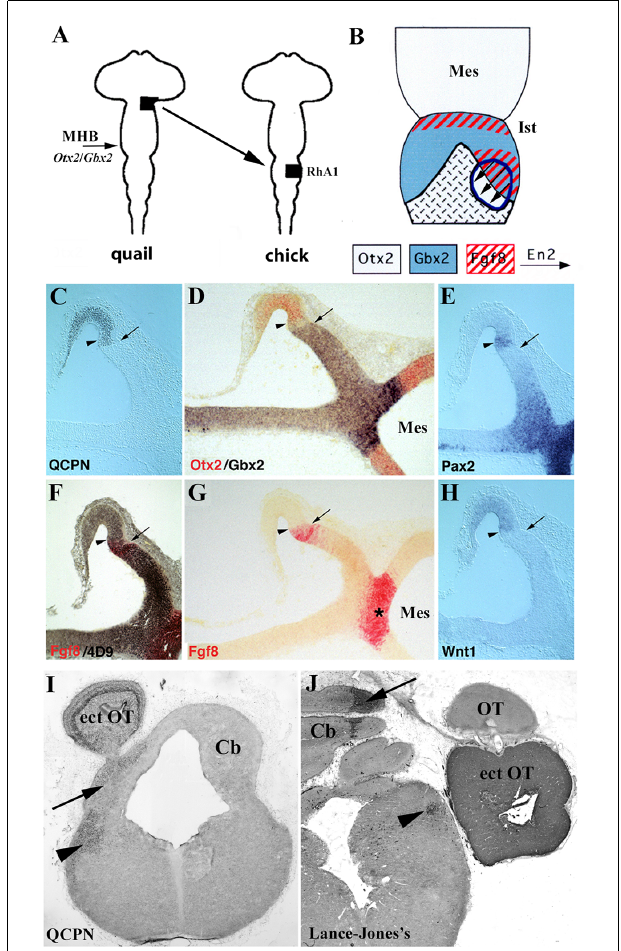
FIGURE 9 | (A) Schematic representation of heterotopic transplant, black areas, of the quail (donor) dp1/dp2 neuroepithelium to the chick (host) pro-rhombomere A1 (RhA1), caudal to the mes/met constriction, performed at stage HH10. (B) Schematic representations of a dorsal view of short survival chimeric embryos. In light gray, Otx2 -positive territories in the midbrain, in the choroid tissue, and in the graft. In blue, Gbx2 positive domains. The red, Fgf8 -positive territories. The arrows indicate the En2 induction. The graft is outlined by blue lines. A new Otx2 / Gbx2 boundary is formed within the graft. (C–H) Serial sagittal sections of a resulting chimeric embryo at stage HH20. The arrows point to the QCPN-positive graft/host interface and the arrowheads to the newly created intragraft Otx2 / Gbx2 boundary. Pax2 , En2, Fgf8 , and Wnt expressions display a pattern on both sides of the intragraft Otx2 / Gbx2 boundary similar to that observed in the host MH domain: the Fgf8 and Wnt1 genes are expressed within the Gbx2 and Otx2 domains, respectively, and Pax2 and En2 (4D9 immunoreaction) form double decreasing gradients centered on this intragraft Otx2 / Gbx2 boundary. The Fgf8 -induced area is undoubtedly separated from the host Fgf8 -positive isthmic ring (asterisk in G ). (I,J) Frontal sections of two long-survival chimeric embryos treated with QCPN (I) and Lance-Jones’s (J) antibodies, which labeled quail cells from the grafts. The transplants form an ectopic optic tectum (ect OT), also contributing to both in situ isthmus (Ist; arrowheads) and cerebellum (Cb; arrows). Mes, mesencephalon; MHB, midbrain/hindbrain boundary; OT, host optic